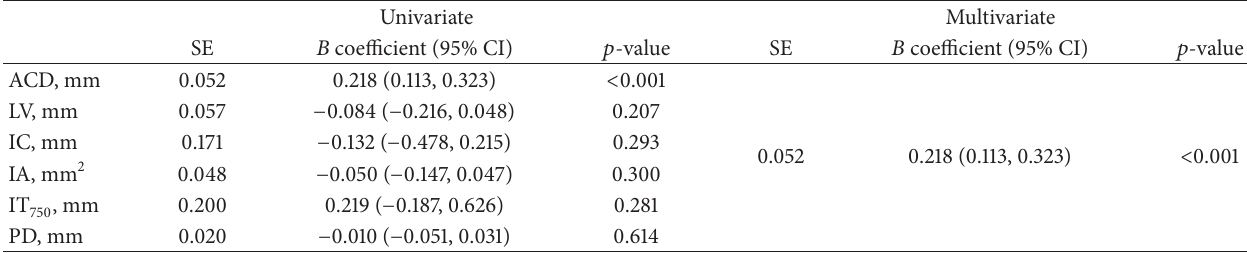
) assessed pre-LPI in the NBG subjects. (AOD 750